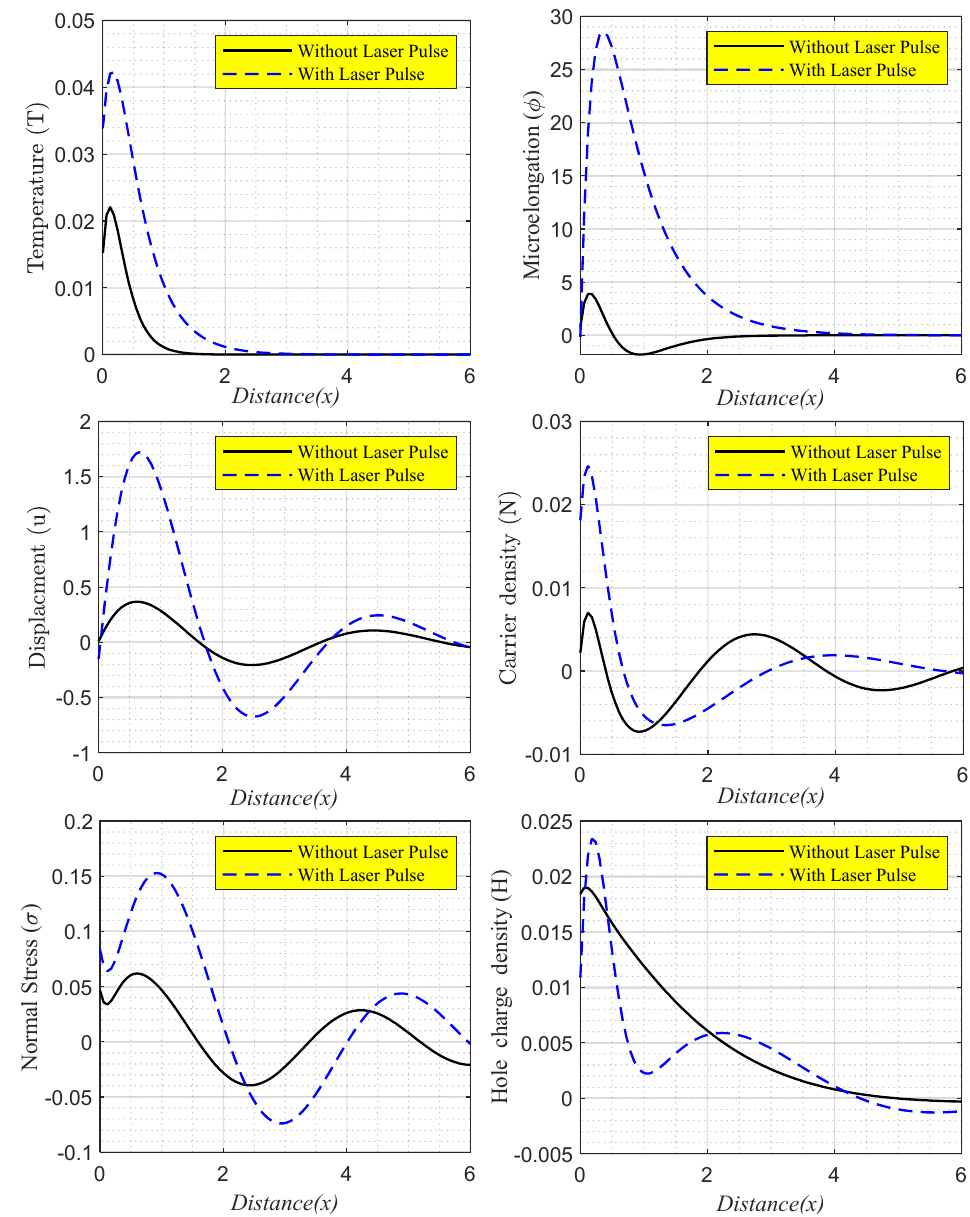
Figure 3. According to the DPL model, the main field distributions in two temperature fields under the impact of laser pulses and without them changing in terms of horizontal distance.